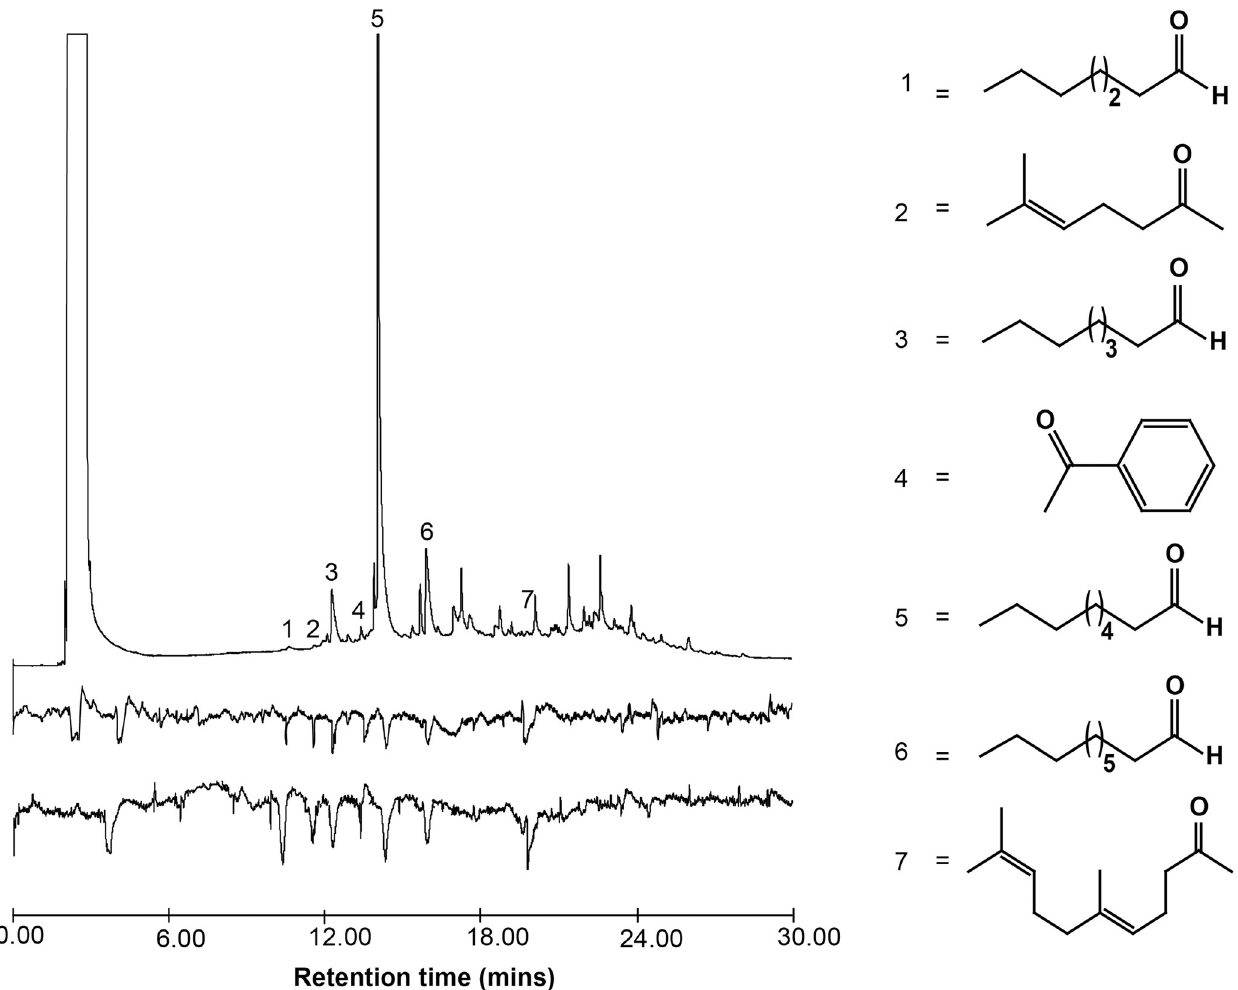
Fig 3. Representative GC/EAD profiles showing antennal responses of G . pallidipes to crude skin odors of zebra. Upper trace is the GC/FID and lower traces represent EAD responses. Chemical structures of the identified EAD-active compounds are shown. 1, heptanal; 2, 6-methyl-5-hepten-2-one; 3, octanal; 4, acetophenone; 5, nonanal; 6, decanal; and 7, geranylacetone. The EAD runs were scaled to 10mV/div.